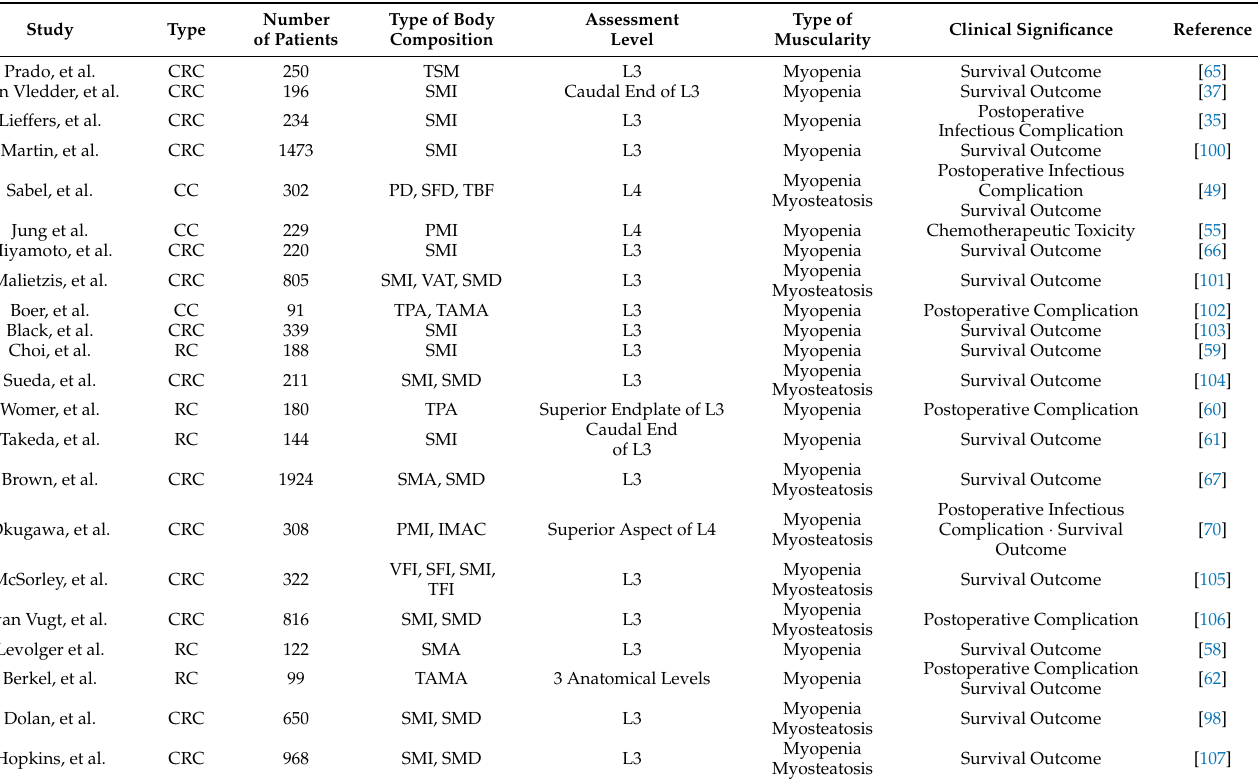
Table 1. Association between body composition status and short-term and long-term postoperative outcomes in patients with colorectal